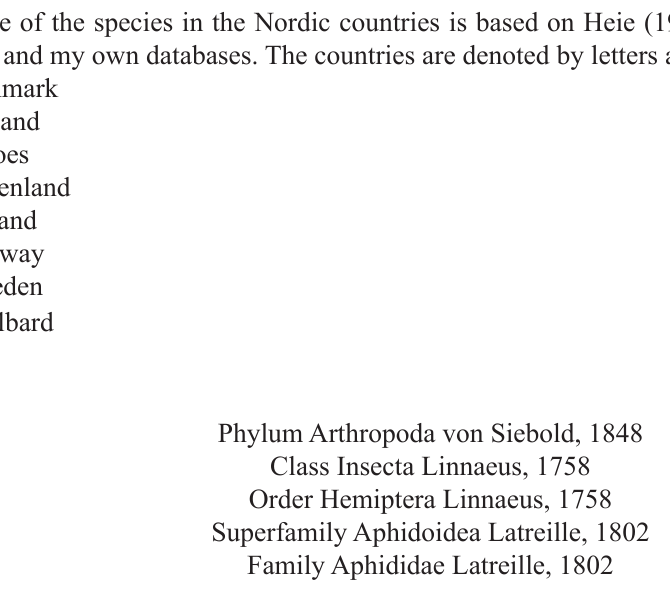
Synoptic key and diagnoses for aphids on mosses, horsetails and ferns For a summary of the host-plant relationships of aphids feeding on mosses, horsetails and ferns, see Appendix 1 and 2. In the diagnoses my own host records and relevant others from the database are denoted by an asterisk (*) after the host name. For geographical and phenological records from Finland, see Albrecht (2010).